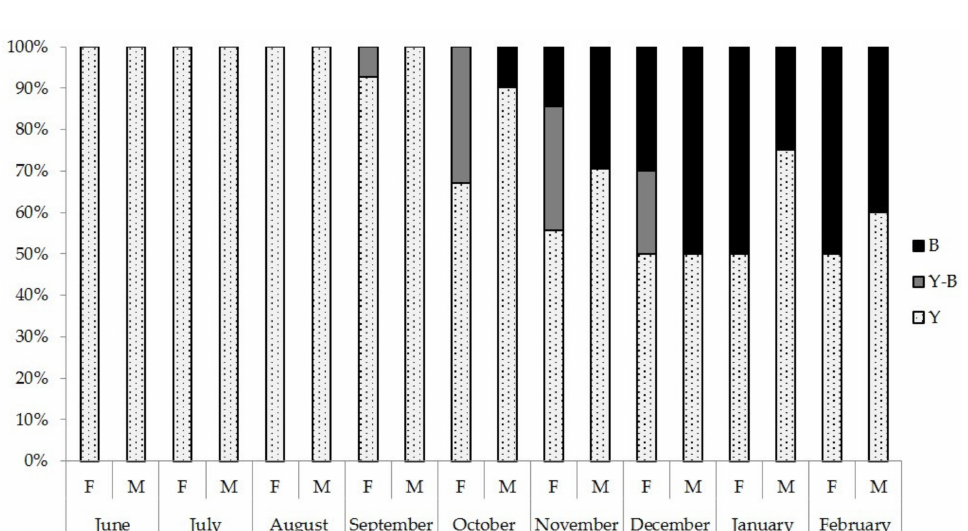
Figure 3. Monthly percentages of Cirrospilus pictus females (F) and males (M) belonging to classes I and IV = yellow (Y), II = yellow–black (Y–B), and III and V = black (B), averaged over the 4 years of observation (2000–2003) detected in the period of active infestation of Phyllocnistis citrella